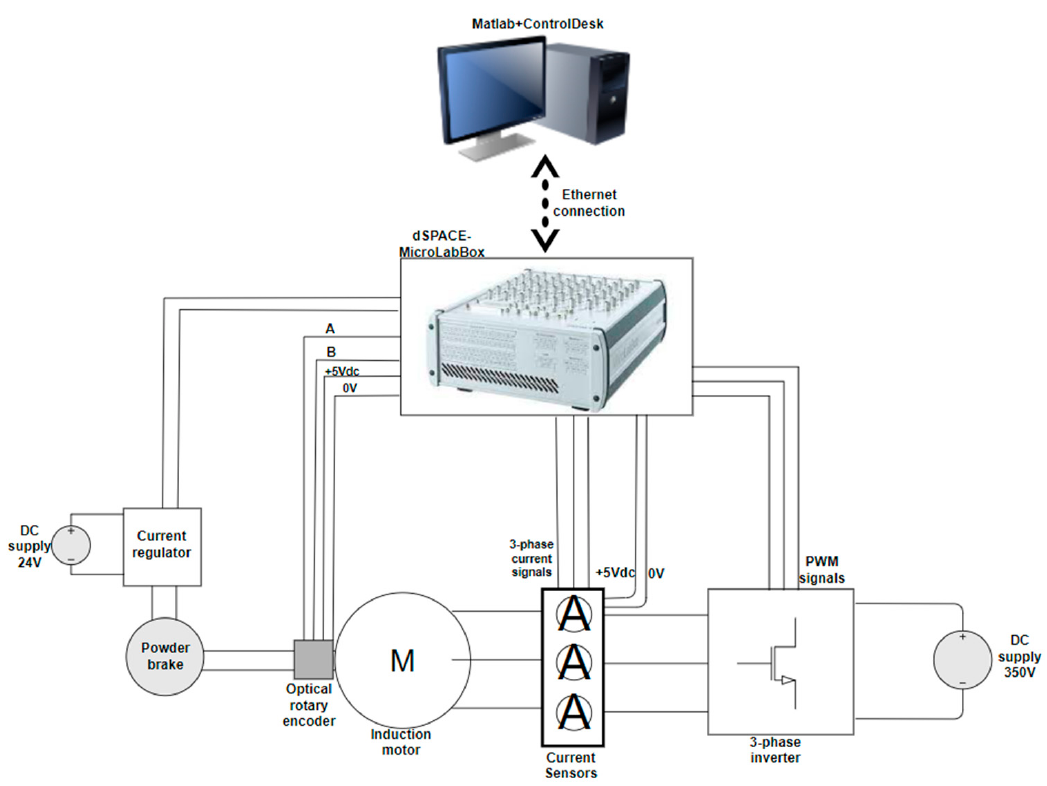
Figure 12. Block diagram of the experimental adaptive cruise control using an indirect vector control induction machine drive system.